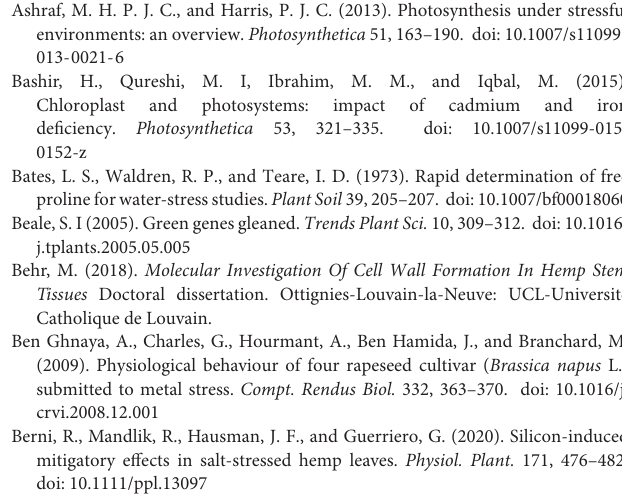
Supplementary Figure 1 | Dry weight (g) of the roots, stems, and leaves of Cannabis sativa (cv. Santhica 27). Plants were exposed for 1 week to cadmium (Cd) (20 µ M) or zinc (Zn) (100 µ M) in the presence or absence of silicon (Si) (2 mM) [C: control plants not exposed to heavy metals (HM)]. The different letters indicate that the values are significantly different from each other ( p < 0.05; Tukey’s HSD all-pairwise comparisons). Supplementary Figure 2 | Confocal microscope observation of hemp leaf sections (60 µ m) (Axioscope 2 MOT, 405 nm). Plants were exposed for 1 week to Cd (20 µ M) or Zn (100 µ M) (C: control plants not exposed to HM). Fluorescence highlights lignified areas (yellow), and areas containing chlorophyll (orange-red color). Scale bar: 200 µ m. Supplementary Figure 3 | Synchrotron-ID21. Cd and Si distribution in the hemp leaf sections (60 µ m) of Cd- and CdSi-exposed plants. Plants were exposed for 1 week to Cd (20 µ M) (C: control plants not exposed to HM). Red arrows: